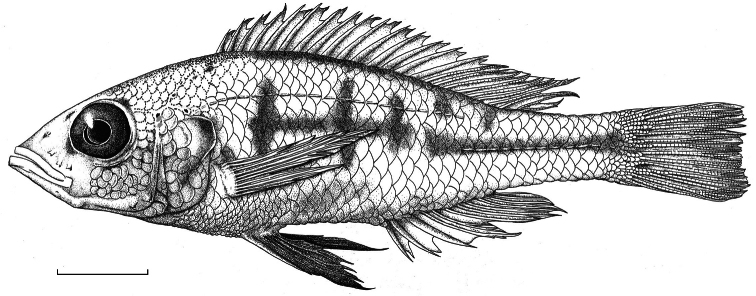
Habitus of Haplochromis argens sp. n. ♂ (holotype, RMNH.PISC.83588). Scale bar equals 10 mm. Drawing by I. Westbroek, missing (= dotted) scales added by M. van Oijen.